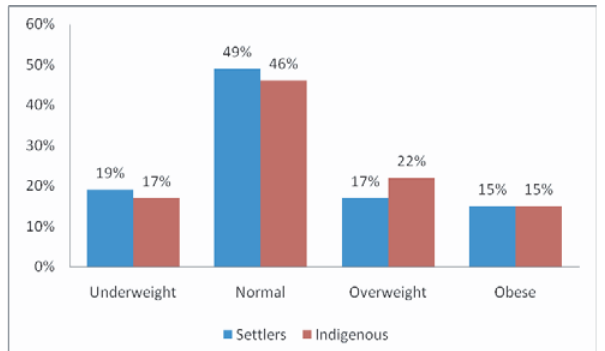
Fig 1. Nutritional status of study subjects Table II: Anthropometric characteristics of the respondents (n=200)